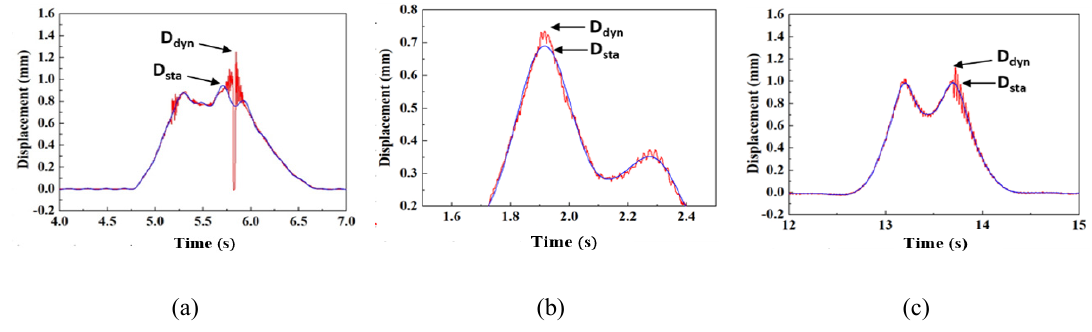
Figure 7. Comparison of the measured vertical rail displacement between dynamic and pseudo-static for each test section: ( a ) section A; ( b ) section B; and ( c ) section C.